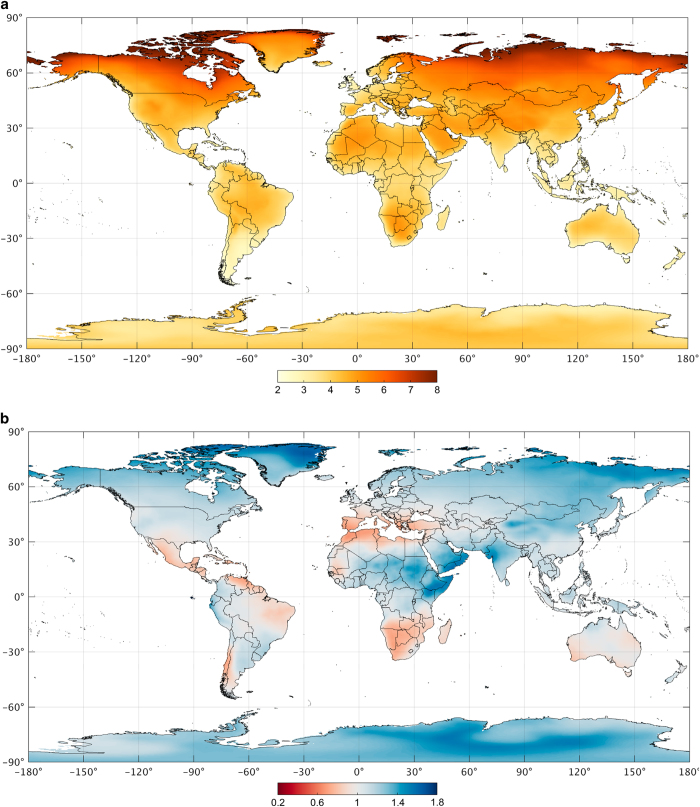
Projected changes in mean air temperature (°C) and precipitation (unitless) between 1980–2016 and 2071–2100 derived from climate model outputs.Part (a) presents air temperature change offsets and part (b) precipitation change factors. The values represent the mean over all models and months.